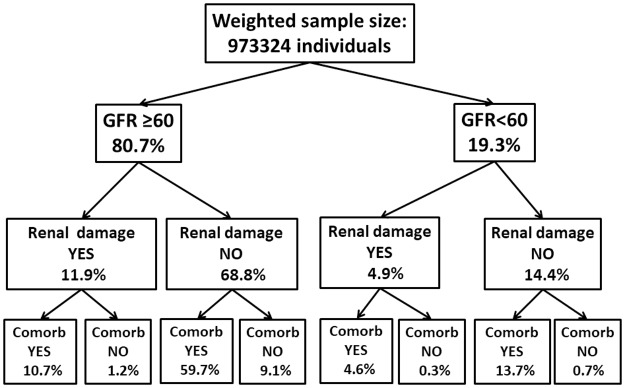
Flow-chart showing the weighted percentage of elderly individuals according to the presence of decreased GFR, renal damage and comorbidities.All the weighted percentages were estimated relative to the entire population, resulting in 100% for each line. Comorb: comorbidities. Decreased GFR defined as GFR <60 mL/min/1.73 m2; renal damage defined as presence of proteinuria/hematuria; comorbidities defined as presence of diabetes, hypertension, metabolic syndrome or cardiovascular disease.